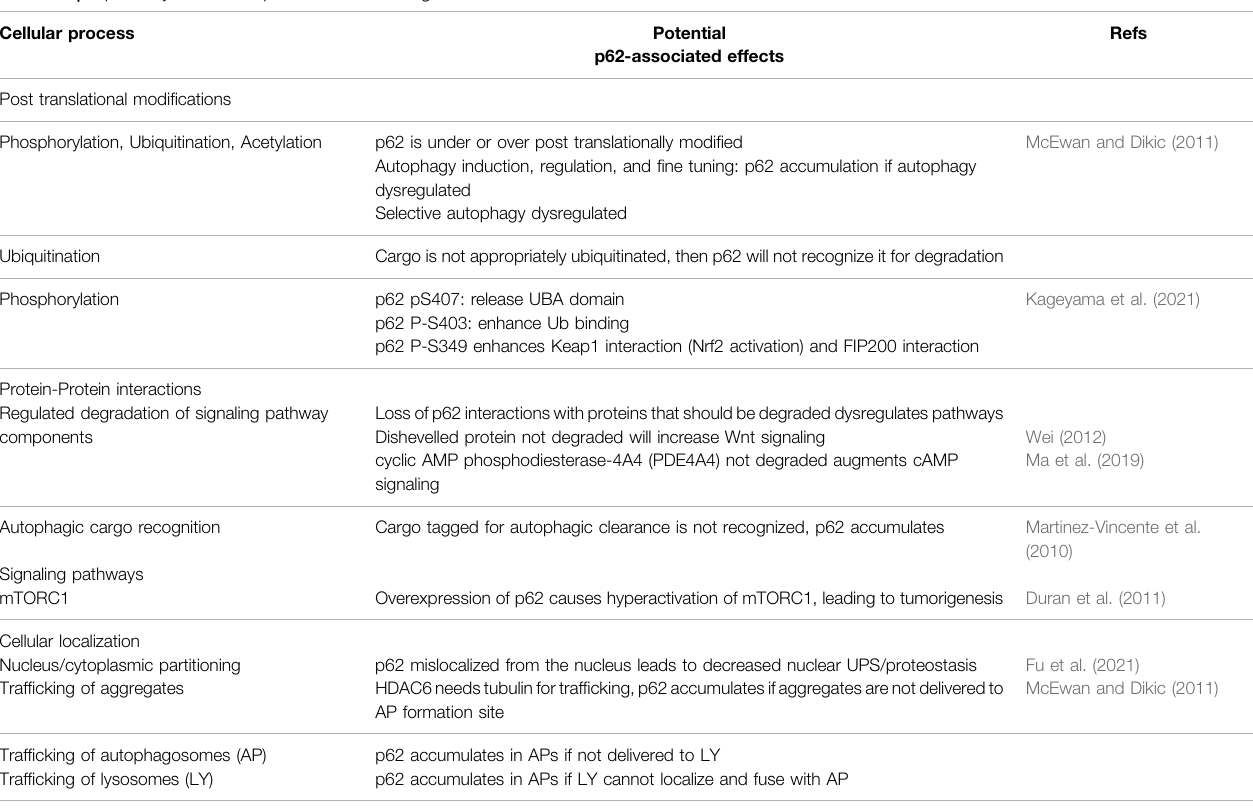
TABLE 1 | Exploratory avenues of p62-associated changes. Cellular